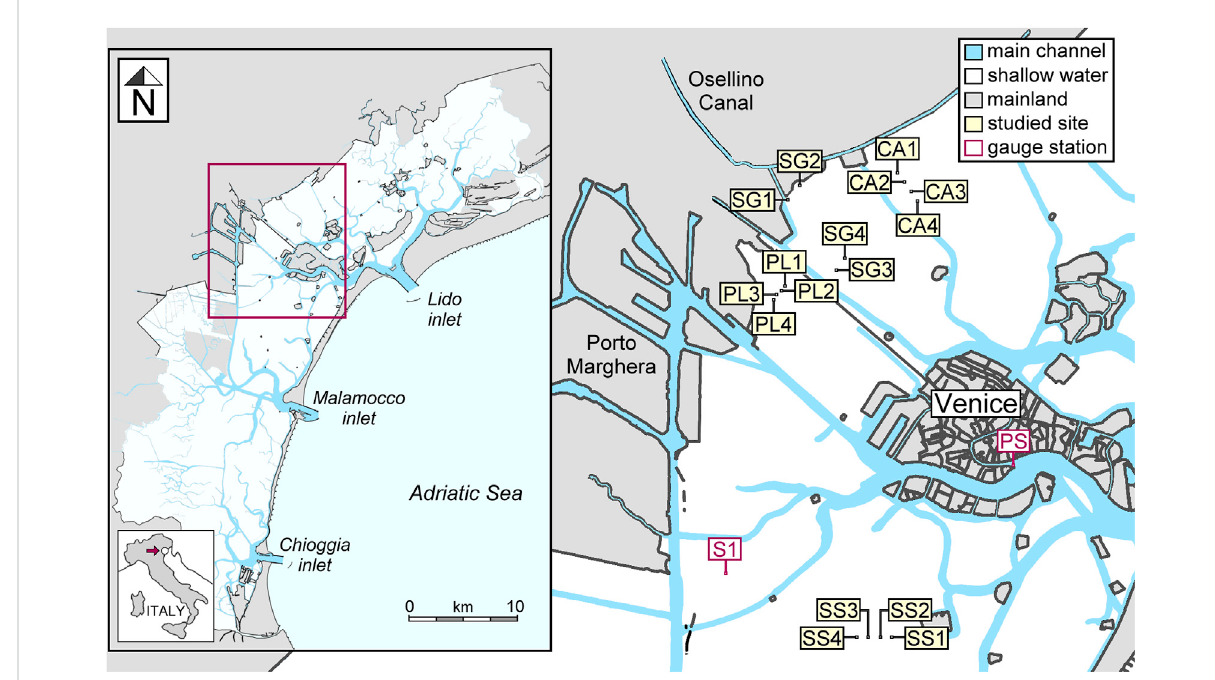
FIGURE 1 Location of the 16 measurement sites in the four selected areas of the Venice Lagoon (in the insert). S1 (45 ° 24.7934 ° N 12 ° 16.4518 ° E) and PS (45 ° 25.8656 ° N 12 ° 20.1826 ° E) identify the DO gauge station of the SAMANET network and the tide gauge of Punta Salute (managed by the Venice Municipality),